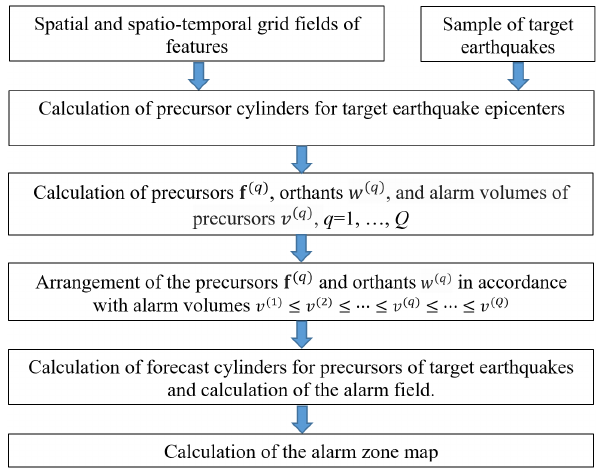
Figure 2. Flowchart of the